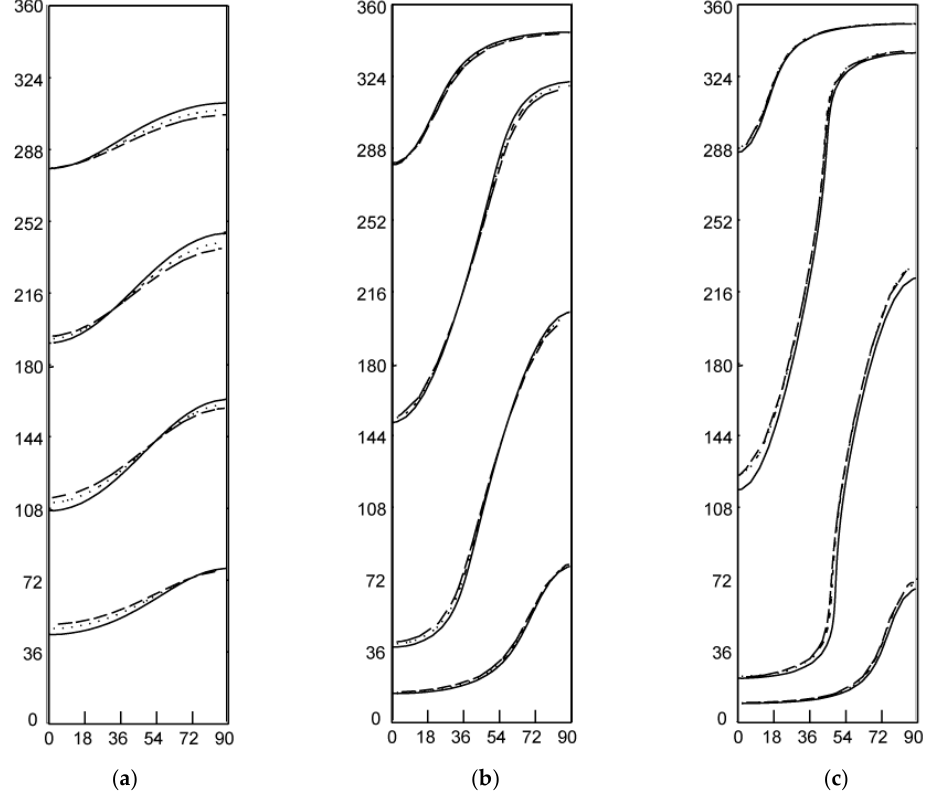
Figure 5. Comparison between network method and finite-difference technique: ( a ) Ra = 200; ( b ) Ra = 300; and ( c ) Ra = 400.